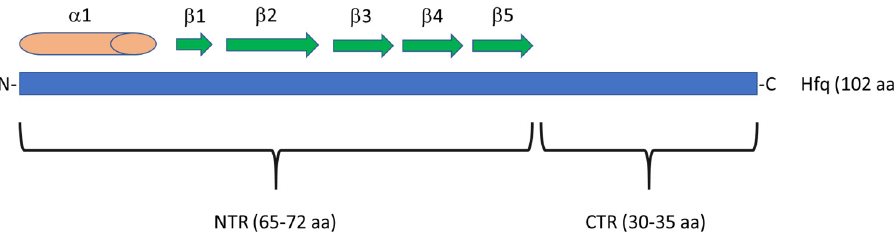
Figure 1. Scheme of the Hfq protein of E. coli . This protein consists of 102 aa residues that can be divided into two regions, NTR and CTR. In NTR, one α helix and five β strands can be distinguished. See [5] for more details. The scheme is not drawn to scale.